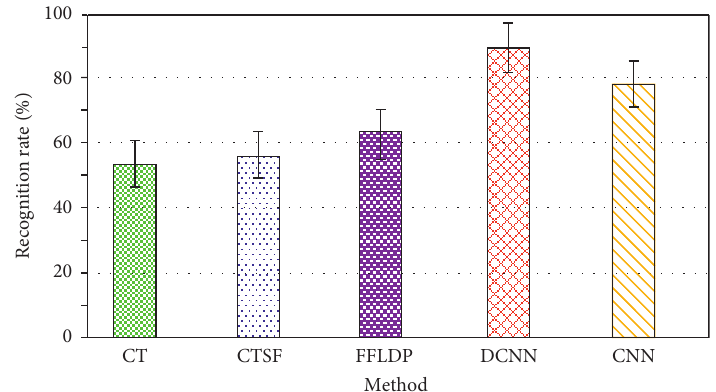
Figure 9: Comparison of recognition rate of pooling methods.